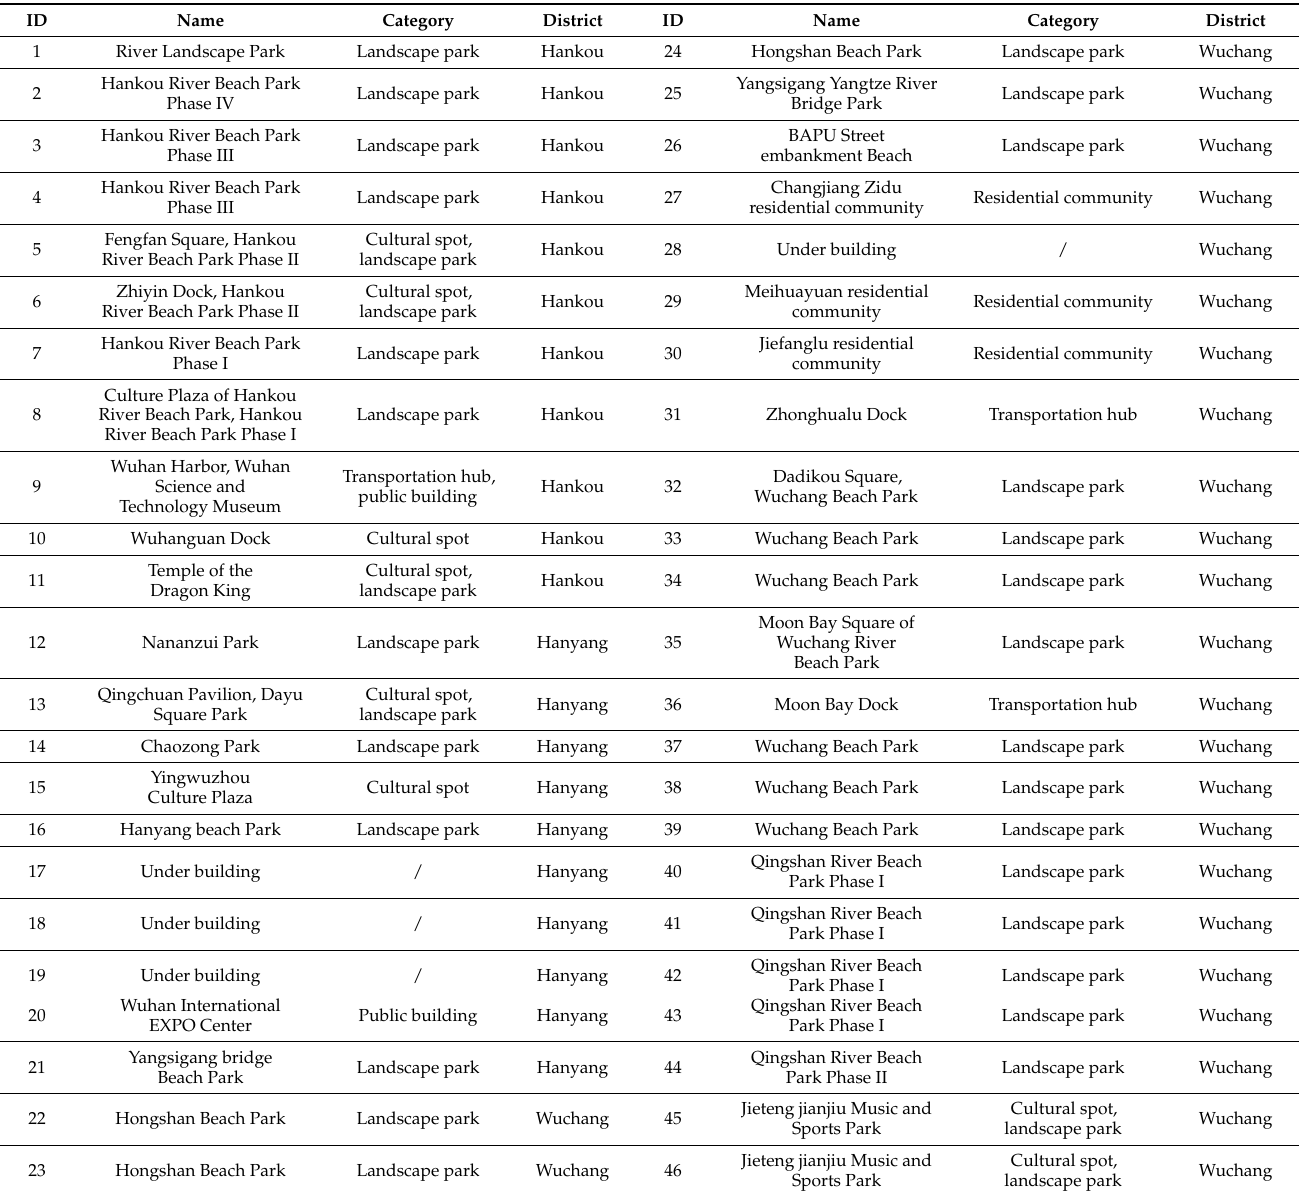
Table 1. The research unit